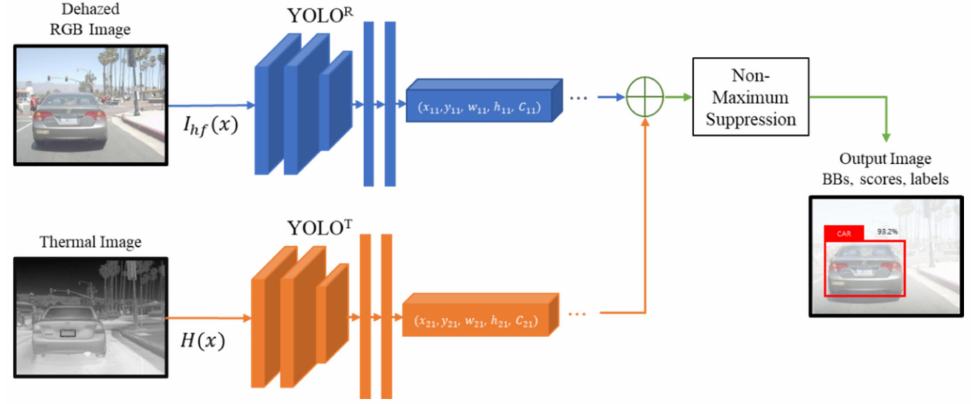
Figure 3. Block diagram of the multimodal YOLO object detection method based on late fusion. The RGB and thermal images are entered into each YOLO, and the B × 2 number of vectors, which shows the location and class of the object, are extracted using NMS and the final bounding box is determined. NMS is connected to the second half of the detection model for improving object detection performance of models like YOLO or SSD to extract the optimal bounding box using the following procedure. First, the bounding box with the highest-class probability against one class is determined and added to the final bounding box list. Second, after comparing the IOU of the selected bounding box and all predicted bounding boxes, if the value is higher than the threshold, the corresponding box is removed. Third, the bounding box with the highest-class probability among the remaining boxes is selected and added to the final bounding box list. After the IOU of the selected bounding box and all remaining bounding boxes are compared, if the value is higher than the threshold, the corresponding box is removed. This process is repeated until no bounding box is left in the